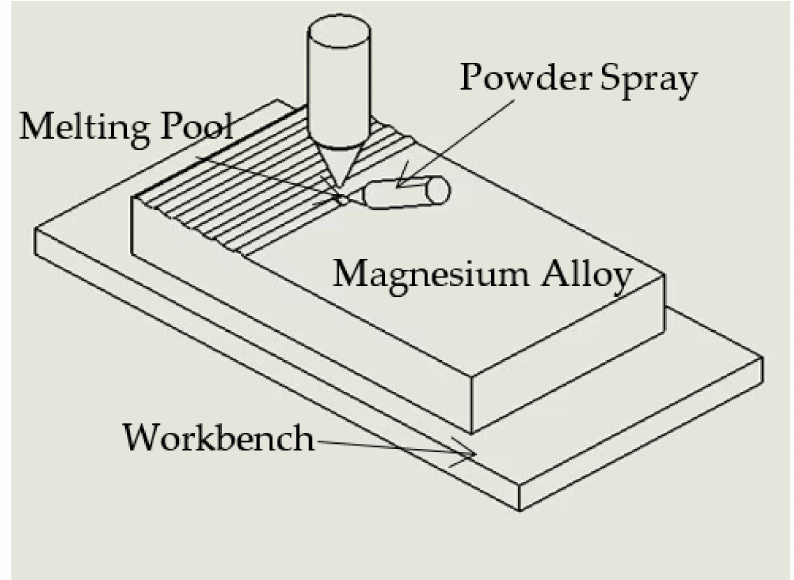
Figure 1. Schematic illustration of the laser cladding